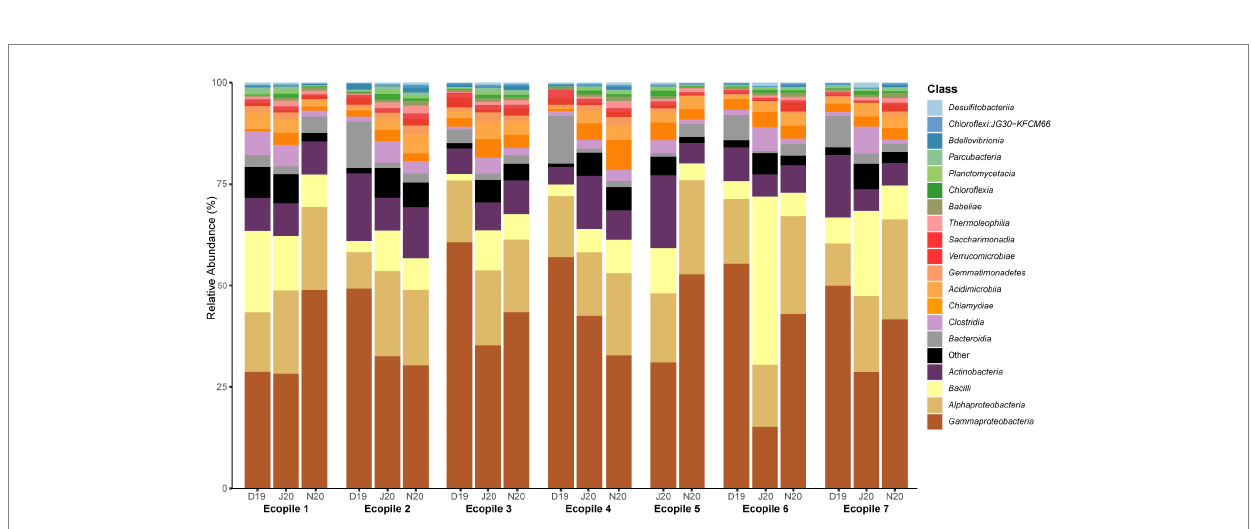
FIGURE 2 Bacterial relative abundances at the level of class for the different Ecopiles at the three sampling times. Relative bacterial ASVs abundance at the level of class of the Ecopiles at each of the timepoints for the 20 most abundant classes. The remaining classes were grouped under the category Other. The barplots represent the sum of ASVs from the three